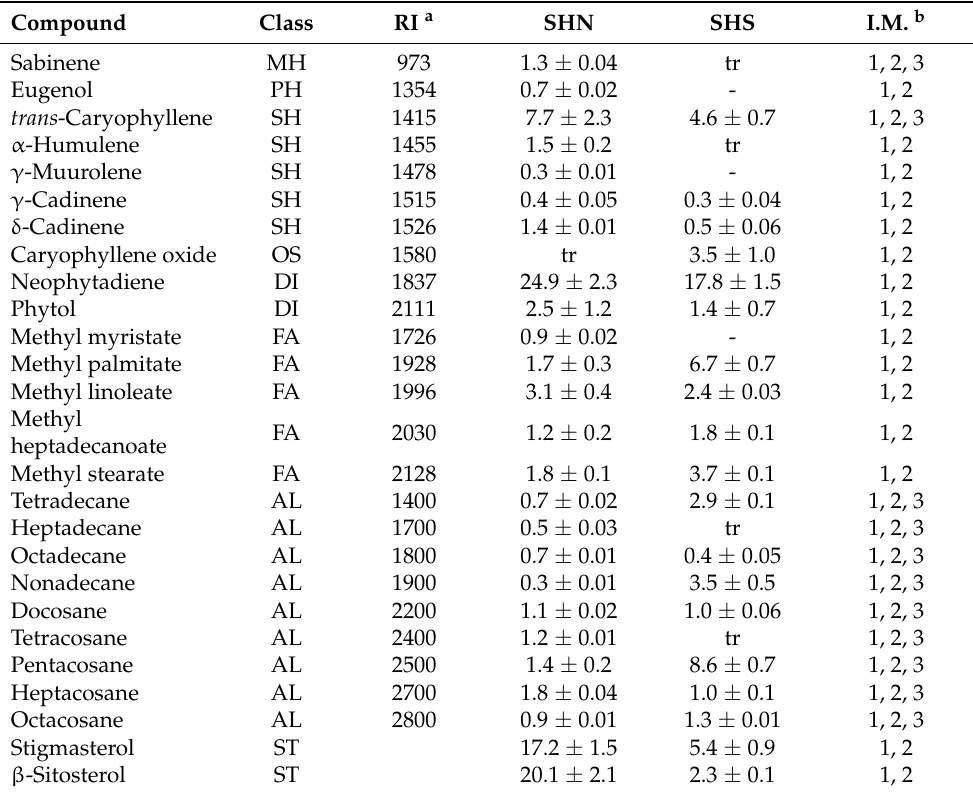
Table 2. The main constituents (%) of S. haematodes n -hexane fractions. Compound Class RI a SHN SHS Sabinene